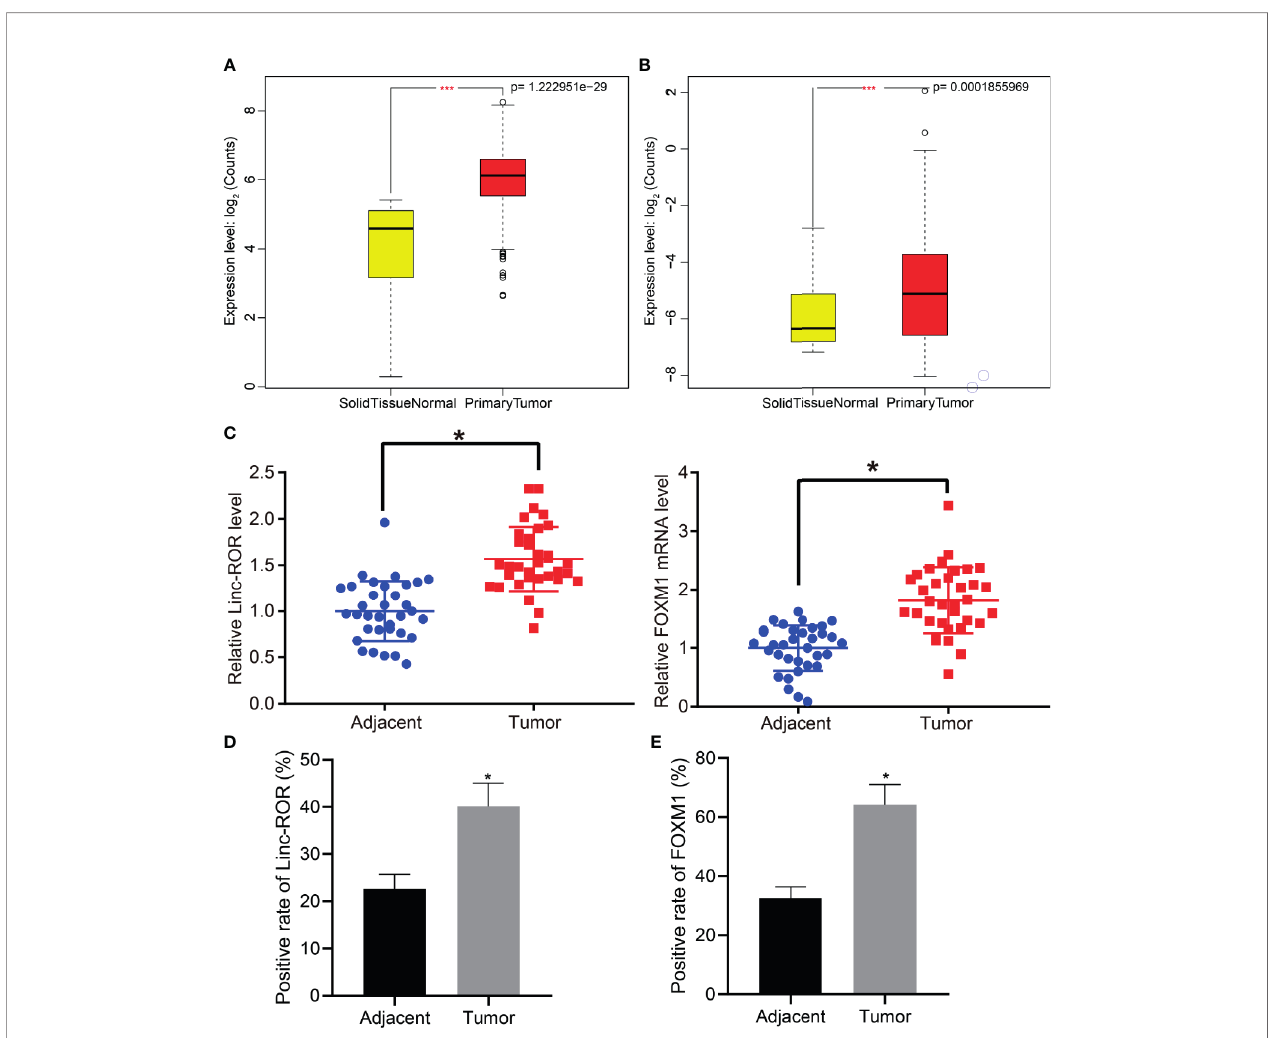
FIGURE 1 | FOXM1 and Linc-ROR are highly expressed in clinical samples of HNSCC patients. (A) Expression of Linc-ROR of HNSCC samples in TCGA database; (B) Expression of FOXM1 in HNSCC samples in TCGA database; in (A, B) , the abscissa axis indicates sample grouping, ordinate axis indicates gene expression count after log2 value; N = 546, *** indicates p < 0.001. (C) RT-qPCR detection of Linc-ROR and FOXM1 expression in HNSCC and adjacent normal tissues of 34 HNSCC patients; (D) Expression of Linc-ROR in cancer and adjacent normal tissues of 34 HNSCC patients determined by in situ hybridization; (E) Expression of FOXM1 in cancer and adjacent normal tissues of 34 HNSCC patients determined by IHC. * p < 0.05, compared with adjacent normal